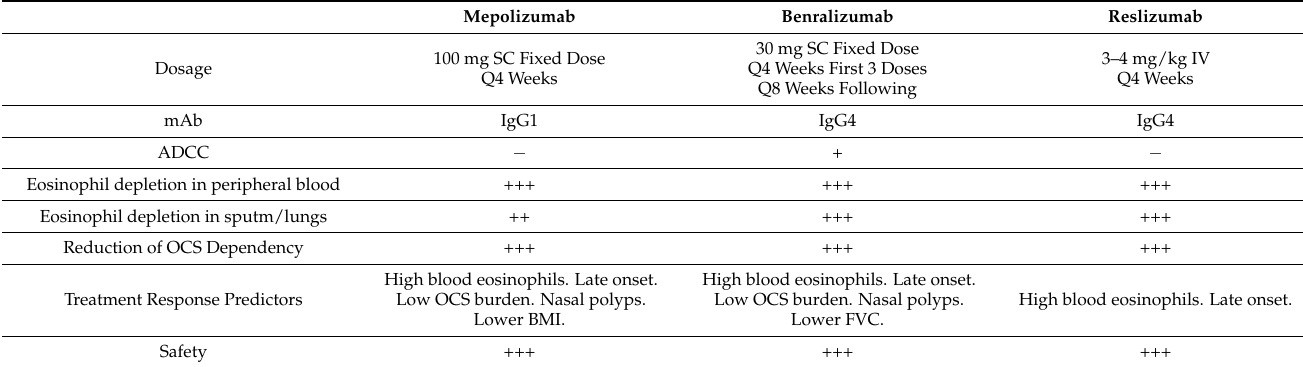
Table 2. Head-to-head anti-IL-5 monoclonal antibody properties comparison. Abbreviations used: SC: subcutaneous, IV: intravenous, mAbs: monoclonal antibodies, OCS: oral corticosteroids, ADCC: antibody-dependent cellular cytotoxicity, BMI: body mass index, (+, ++, +++) denote incremental strength of effect.